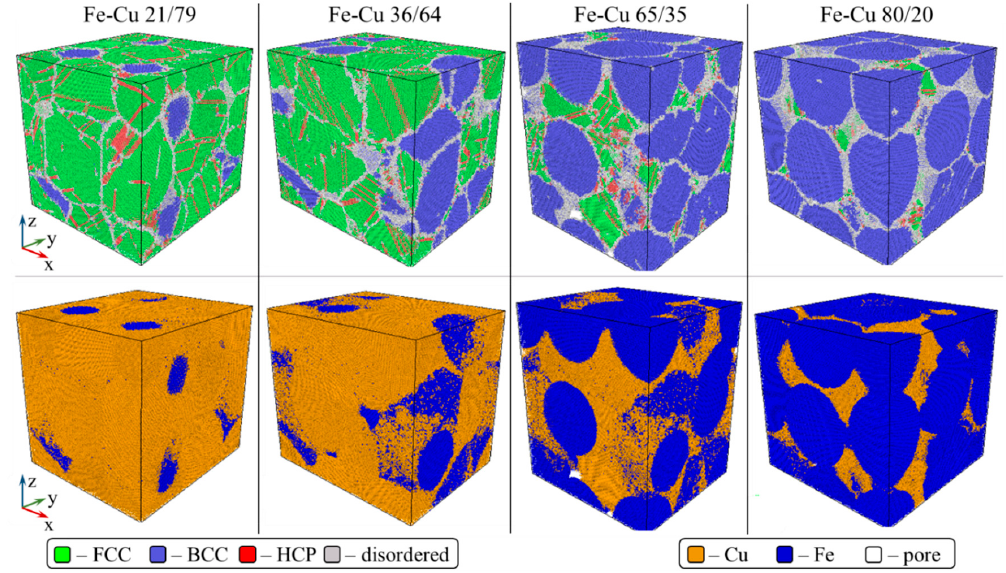
Figure 6. Crystal structure (upper row) and elemental distribution (lower row) of simulated 21/79, 36/64, 65/35, and 80/20 Fe–Cu samples cold sintered at 3